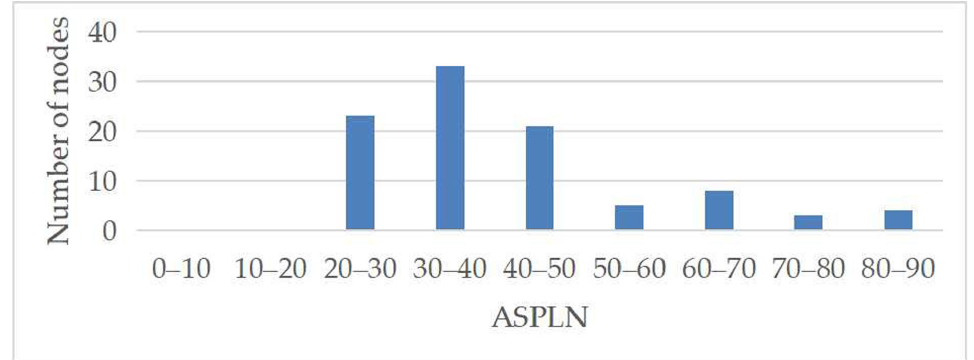
Figure 8. ASPLN of the highway network.